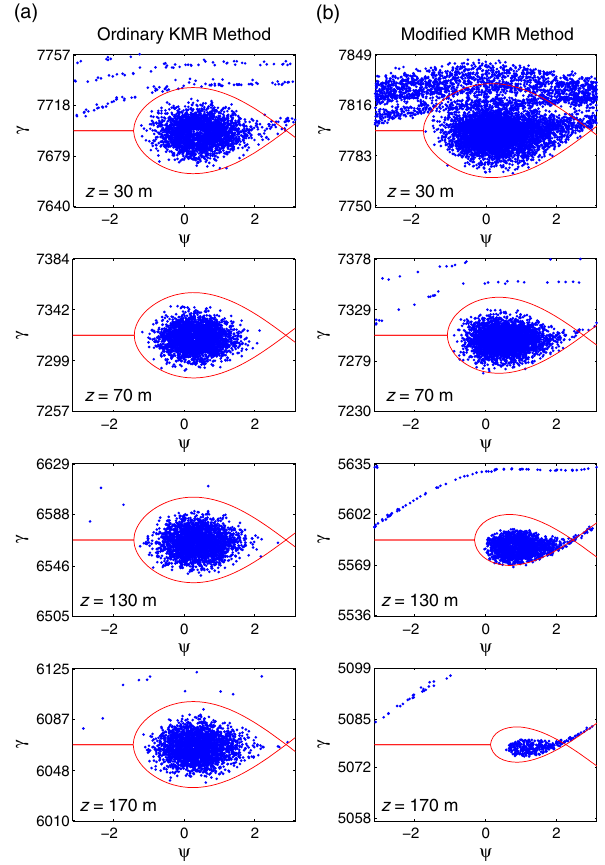
FIG. 2. The ð ψ ; γ Þ phase space at four different z positions for ¼ 0 . 26 rad) and (b) modi- the (a) ordinary KMR method (with ψ R fied KMR method (with g ¼ 5 mrad = m). The separatrices of the ponderomotive bucket are shown in